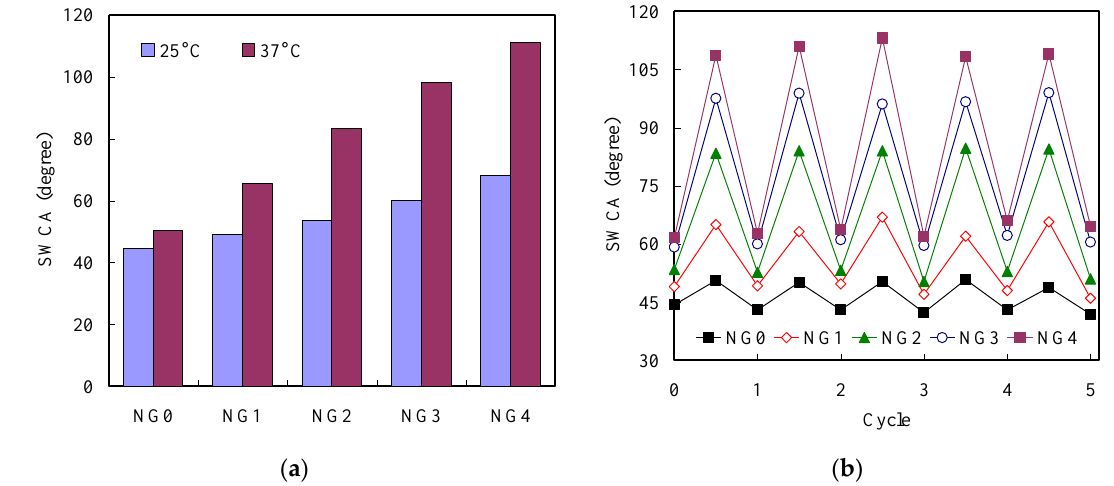
Figure 5. ( a ) SWCAs of NG0, NG1, NG2, NG3, and NG4 at 25 and 37 °C, respectively. ( b ) Variations in SWCAs of NG0, NG1, NG2, NG3, and NG4 during five cycles of temperature switching between 25 and 37 °C.